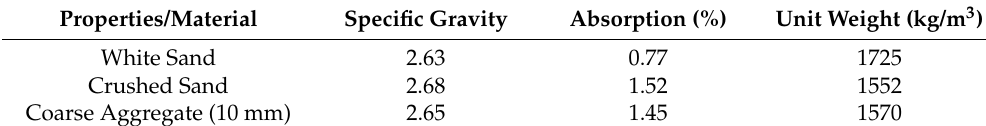
Table 2. Physical properties of fine and coarse aggregate.